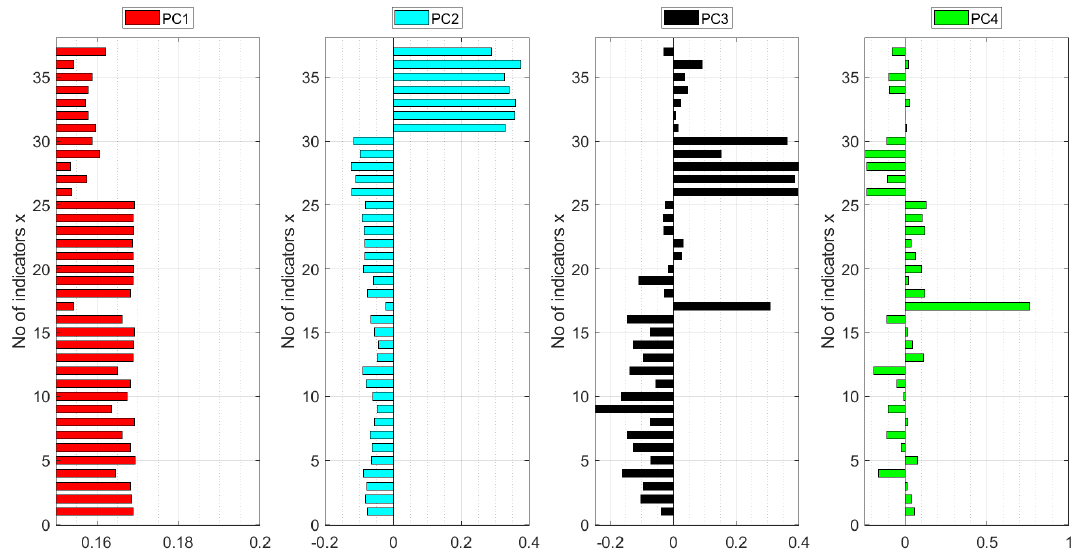
Figure 7. The coefficients for first four principal